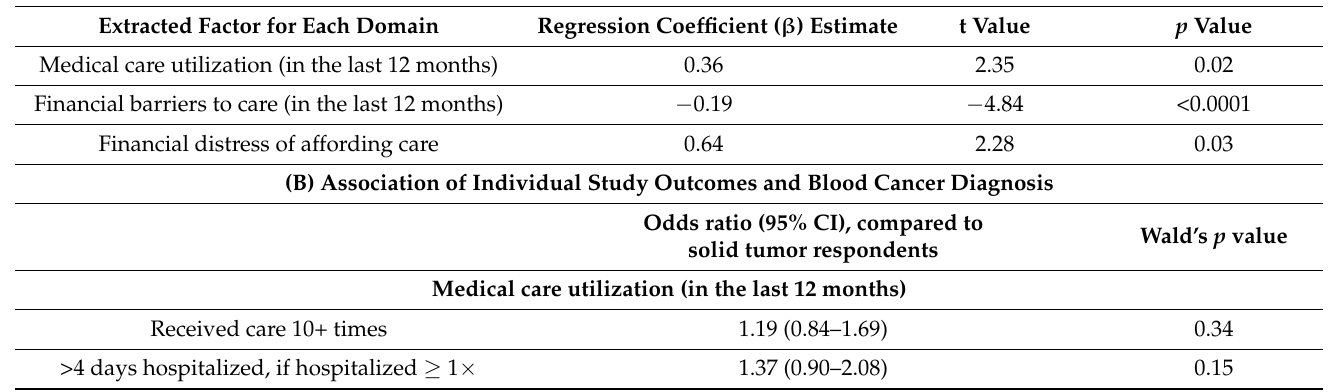
Table 3. Multivariable regressions of ( A ) extracted domain factors and blood cancer diagnosis and ( B ) individual outcomes and blood cancer in the domains of medical care utilization, financial barriers to care, and financial distress of affording care, 2014–2020 a .